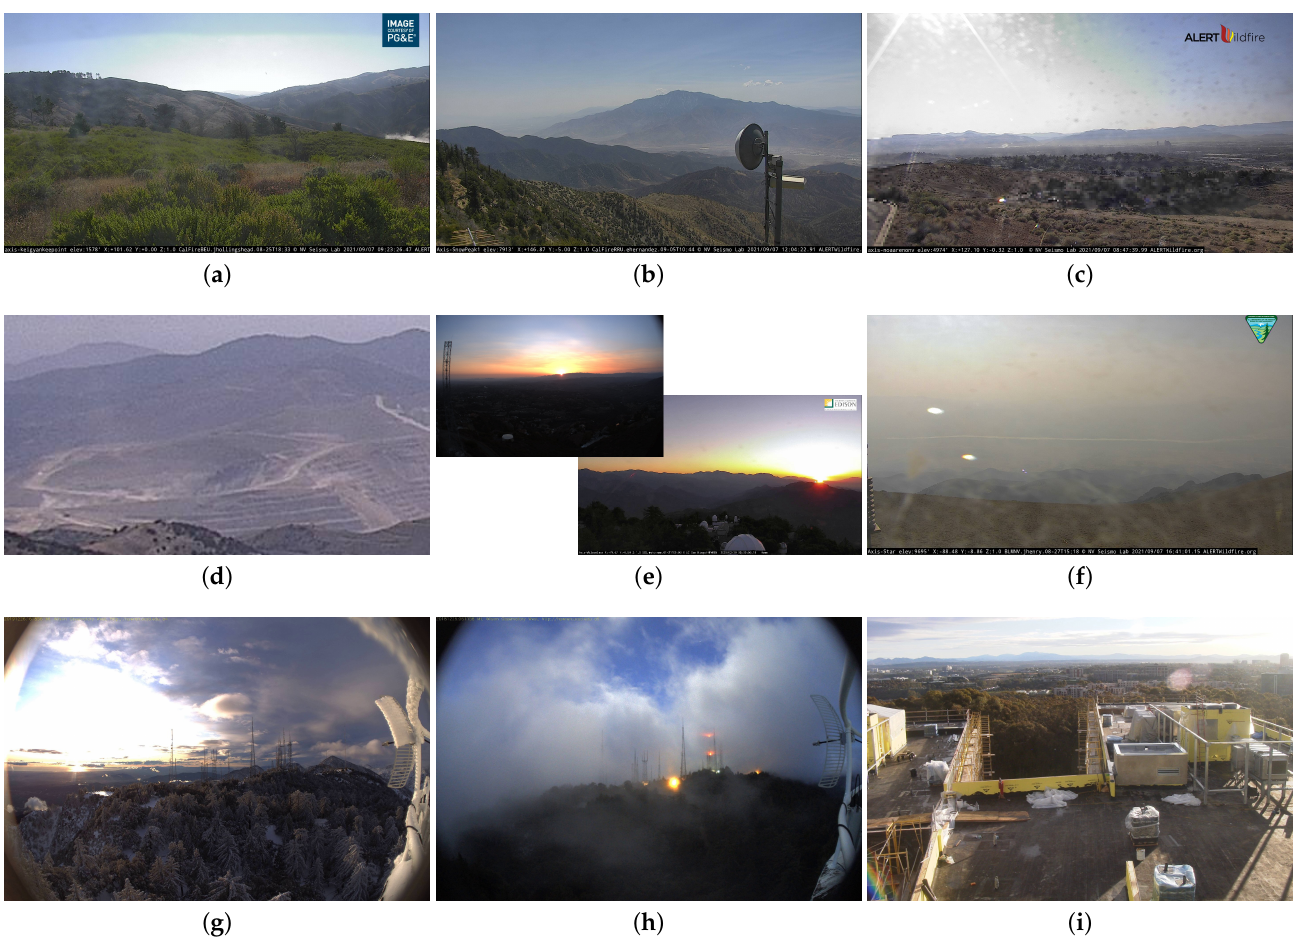
Figure 4. Examples of smoke-like objects. Most images are from Nevada and California wildlands and the Sierra Mountains. ( a ) Small cloud on the right. ( b ) Cloud on a mountain top with hazy background. ( c ) Dirty lens, reflection, and smog. ( d ) Small pile of dust resembles smoke at an early stage. ( e ) Sunset and sunrise. ( f ) Heavy dust, glare, and smudge. ( g ) Tiny, low-altitude cloud, and snow. ( h ) Heavy fog and yellow flood light. ( i ) Miscellaneous objects and